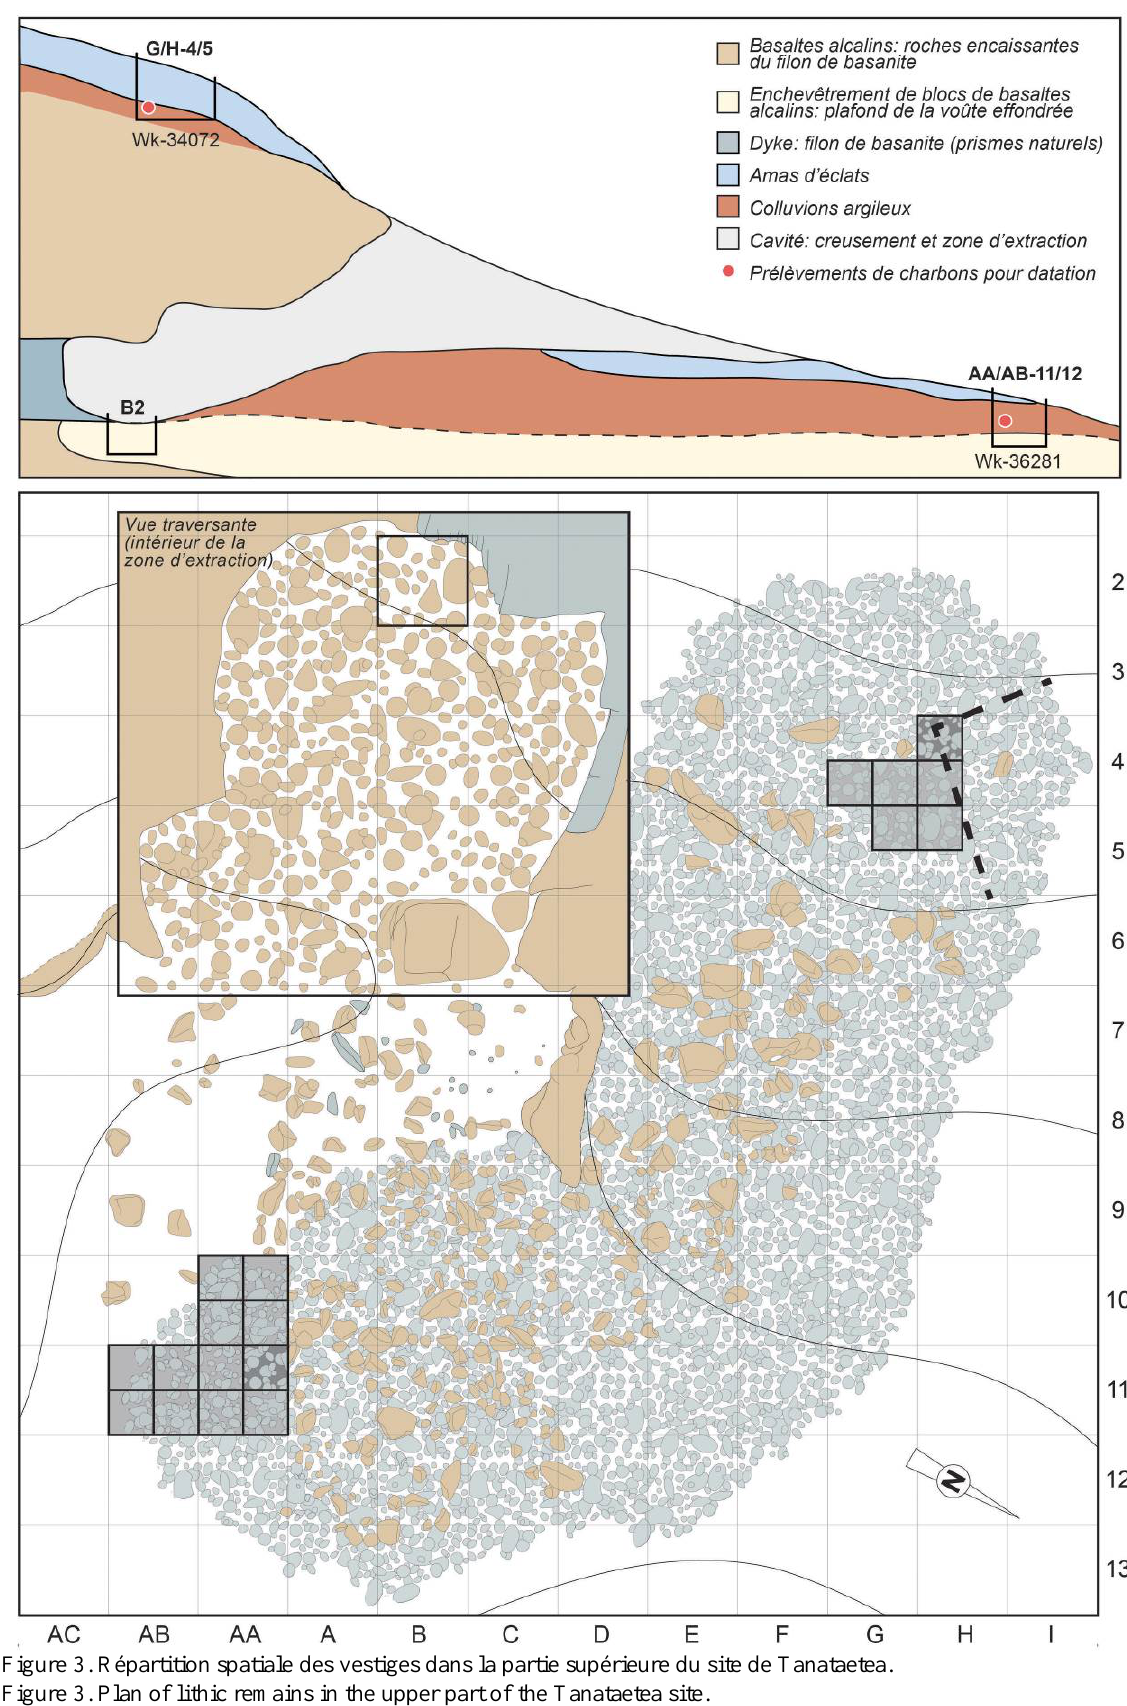
Figure 3. Répartition spatiale des vestiges dans la partie supérieure du site de Tanataetea. Figure 3. Plan of lithic remains in the upper part of the Tanataetea